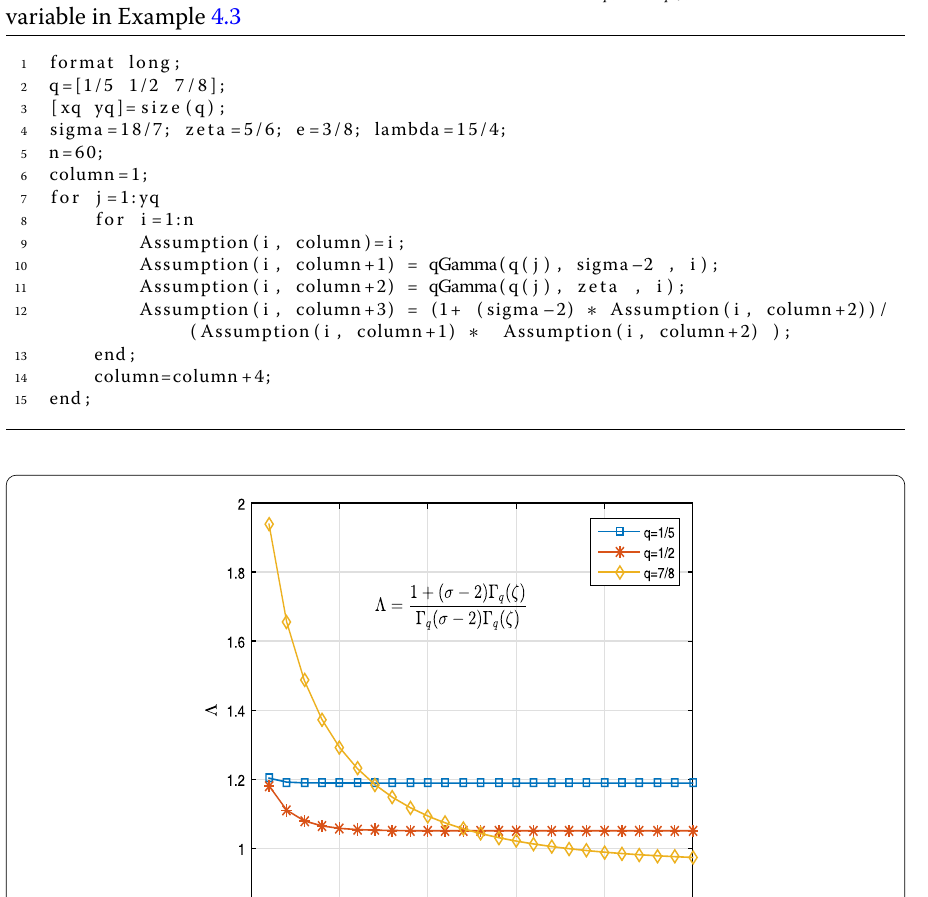
Figure 5 2D graphs of (cid:19) = 1+( σ –2) (cid:12) q ( ζ ) (cid:12)